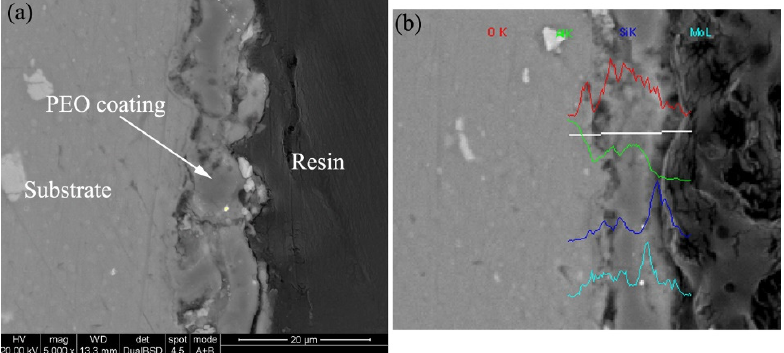
Figure 1. SEM morphologies and EDS of the MAO coatings: ( a ) coating A, ( b ) coating B, ( c ) coating C.